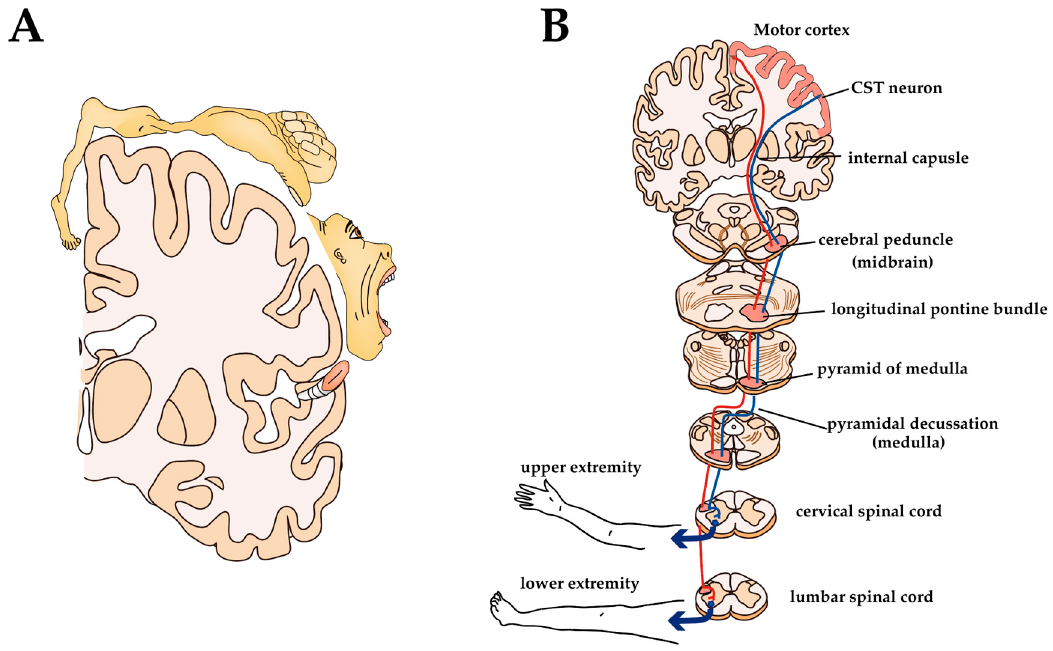
Figure 4. Somatotopic representation of M1 and anatomy of CST in humans: ( A ) Somatotopic motor representations in the human M1; ( B ) Anatomy of CST.